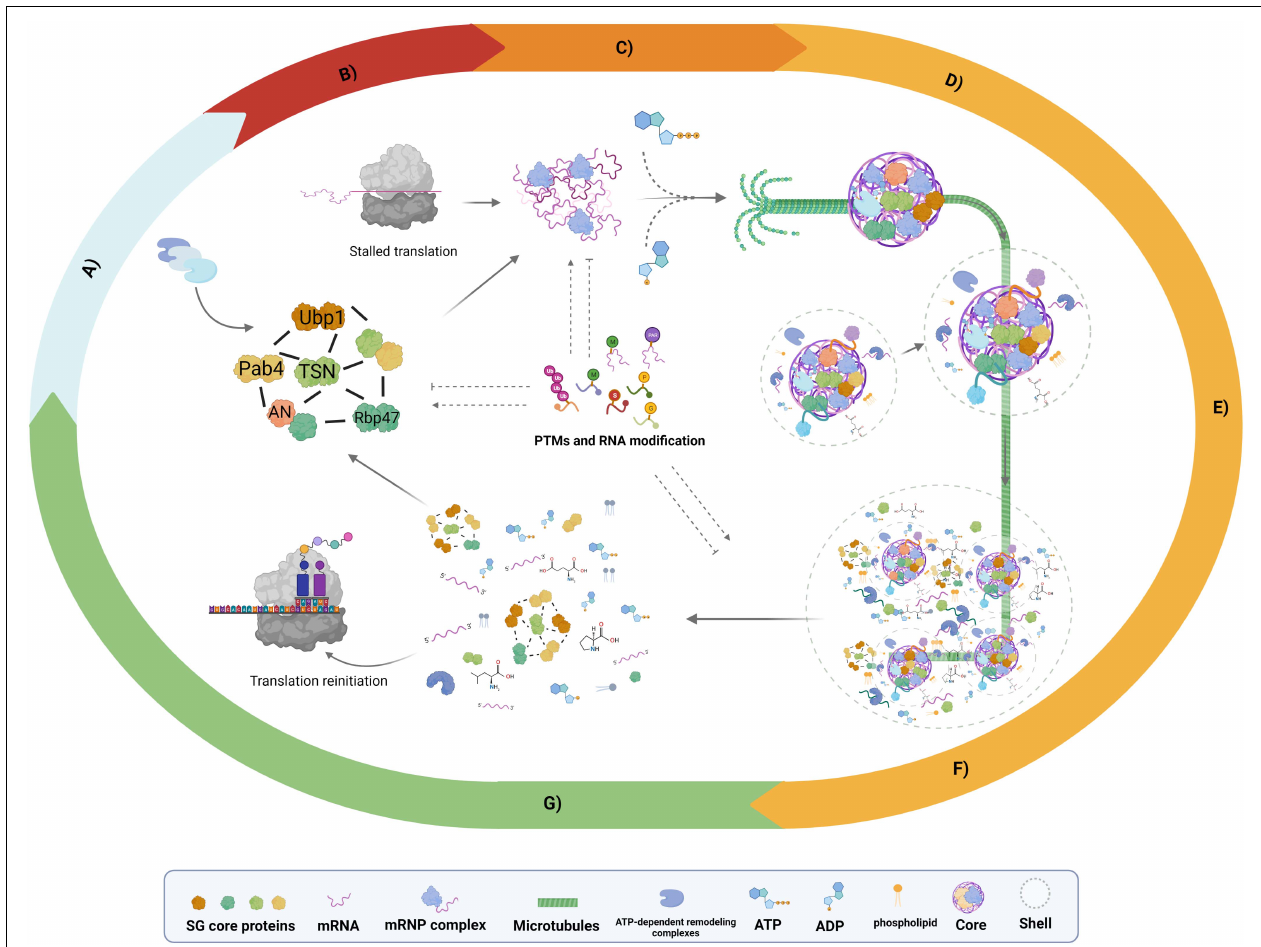
FIGURE 1 | Proposed model stress granule (SG) assembly and disassembly. Schematic representation of SG dynamics based on accumulated evidence of non-plant and plant models. (A) Preexisting protein network, experimental evidence revealed protein–protein interaction (PPI) networks of SG core proteins such as RNA-binding protein 47b (Rbp47), tudor staphylococcal nuclease (TSN), PAB4, and angustifolia (AN) proteins under non-stress conditions. (B) Stalled translation, a global reduction in translation under stress response generates an mRNA-ribonucleoprotein (mRNP) influx essential for SG assembly. (C) Nucleation, high concentrations of mRNP induce liquid–liquid phase separation (LLPS) of mRNP complexes. (D) Core growth, the recruitment of additional SG components to nucleated mRNP drives the establishment of visible core structures; this phase is an ATP- and microtubule (MT)-dependent process. (E) Shell growth phase, once the core structure is defined, additional mRNPs, specific proteins, small molecules, nucleotides, amino acids, and phospholipids are recruited as shell components. (F) Fusion phase, after the formation of individual SGs, fusion events with adjacent SGs take place to assemble a multicore structure immersed in a single shell. (G) SG disassembly occurs after stress during the recovery period. The SGs begin with shell dissociation, followed by the core disassembly, the ATP-dependent remodeling complexes are crucial in this step. The upper box denotes the elements presents in the scheme. Posttranslational modifications (PTMs) and